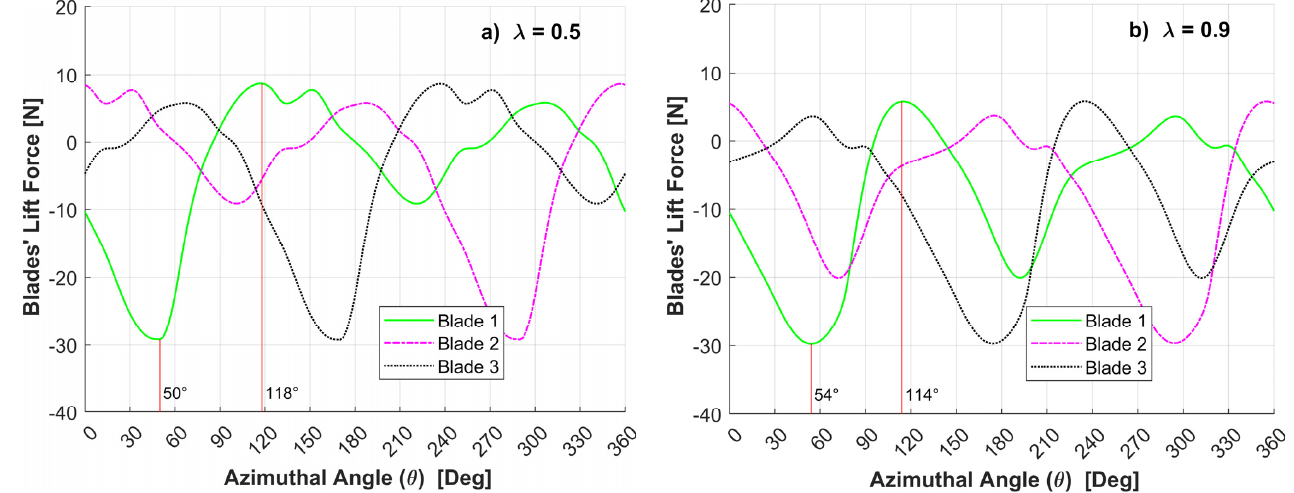
Figure 10. Lift Force for Blades 1, 2 and 3 at Various Azimuthal Angles, for U ∞ = 8 m/s at ( a ) λ = 0.5 and ( b ) λ = 0.9, Using the 2D Model of the Present Study.